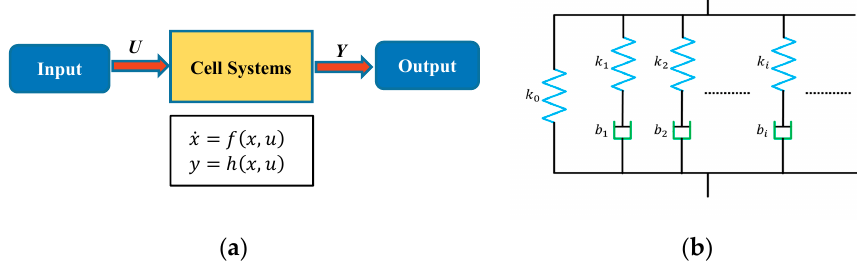
Figure 2. ( a ) Schematic diagram showing the system sciences point of view of cell dynamics; ( b ) An n th-order general Maxwell model of viscoelastic materials.